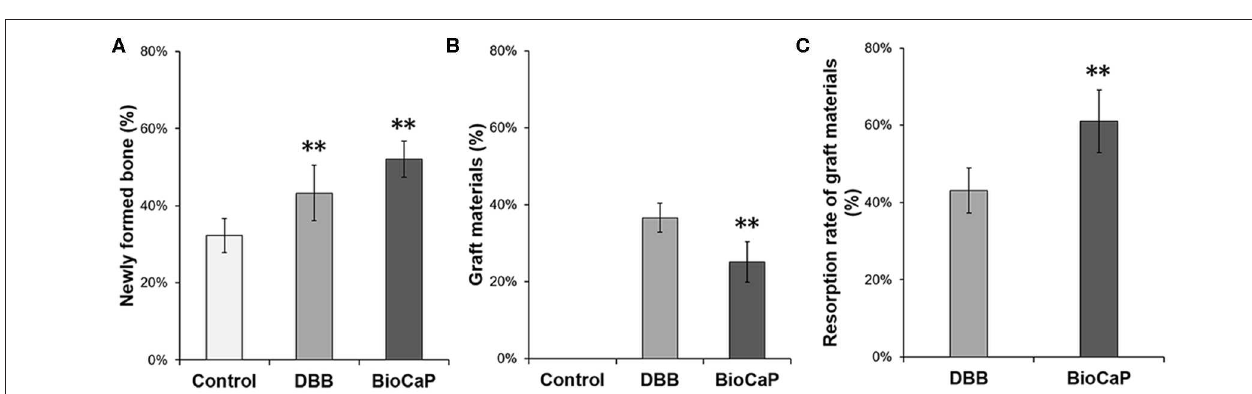
FIGURE 2 | Representative histological images of the bone defect slice in DBB group and Bio-CaP group. (A) Bone remodeling process in DBB group at week 8. (A1) High-resolution image of (A) . (B) Bone remodeling process in BioCaP group at week 8. (B1) High-resolution image of (B) . Yellow arrows, multinucleated cells; asterisk, newly formed bone; black arrow, fibrous tissue; black triangle, blood vessel like structure.